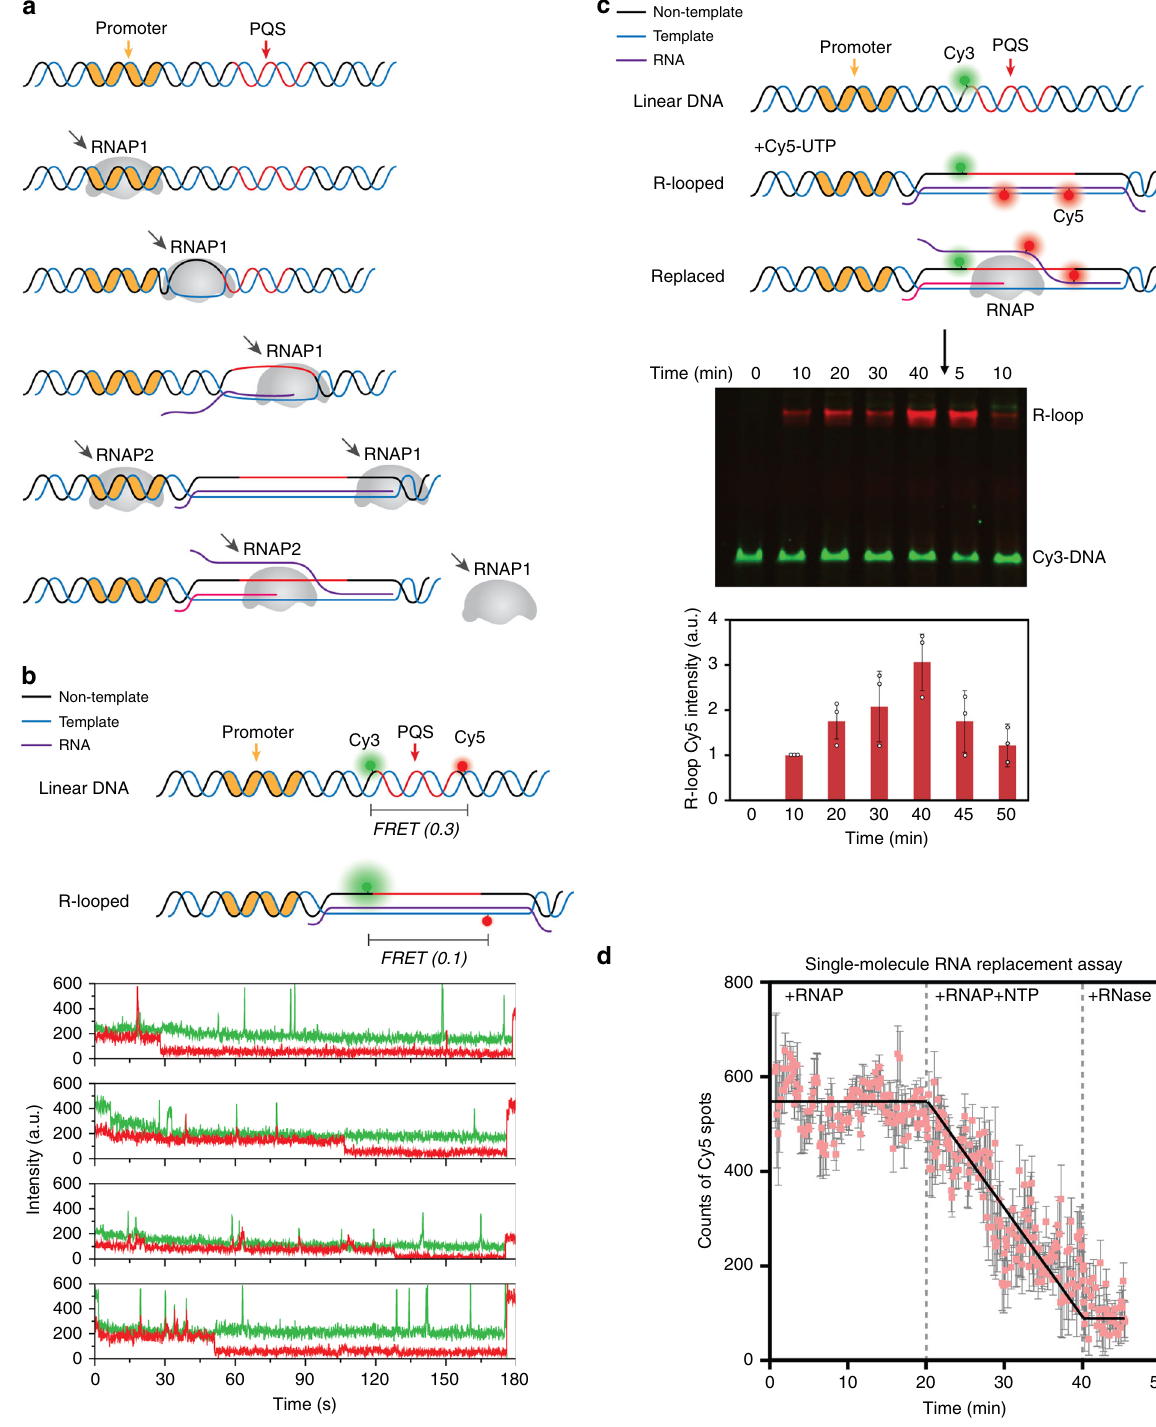
Fig. 6 R-looped state is transcription active state. a The proposed model to show how R-loop is synthesized and replaced during transcription. b Scheme (top) and trace examples (bottom) show that the transition from 0.4 state to 0.1 state is not caused by photobleaching, which is con fi rmed by switching to 641 nm (red) laser to excite Cy5 at last 50 frames of each movie. In addition, the PIFE signal of Cy3 indicates the transcription event still continues. c Scheme of single-molecule replacement assay (top). Cy3-labeled DNA construct is incubated with Cy5-UTP and other NTP mix. The color of Cy3 and Cy5 are used to visualize DNA (Cy3) and R-loop RNA (Cy5) in the EMSA gel (middle). Fresh non-Cy5-UTP is added after 40 min incubation and replaces the Cy5 R-loop, which causes the decrease of Cy5 signal (bottom). Shown in the middle is a single representative image of n = 3 independent experiments, presented by overlaying Cy3 and Cy5 emission. Source data of full scan image and molecular marker is stained separately and provided as Source Data fi le. Quantitative data are presented as mean ± SME and exact values are provides in Supplementary Table 3.10. d Cy5 counts from sm-replacement assay shows decrease of Cy5 spots. Each stages are negative control (RNAP only), test (fresh RNAP with non-Cy5 NTP), and fi nal digestion by RNase